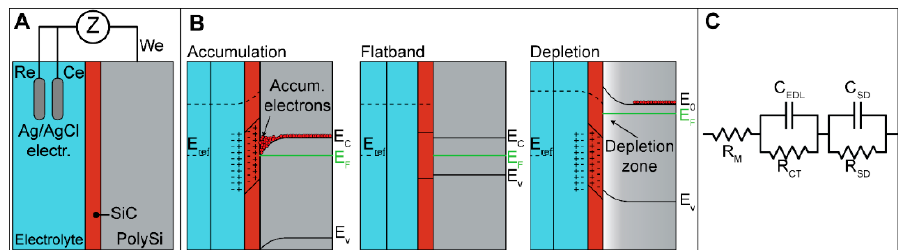
Figure 8. Blank setup measurements. ( A ) Blank sample immersed in the KCl electrolyte. ( B ) Band diagram of a layered structure composed of the semiconductor poly-Si, a dielectric, and an electrolyte. Accumulation for V GS < 0, flat band for V GS = 0 V, and depletion for V GS > 0 V. ( C ) Equivalent circuit used to fit the impedance data. R M is the electrolyte resistance, R SD and C SD are the resistance and the capacitance associated with the dielectric coating, R CT is the charge transfer resistance, and C EDL is the Helmholtz capacitance due to the EDL.